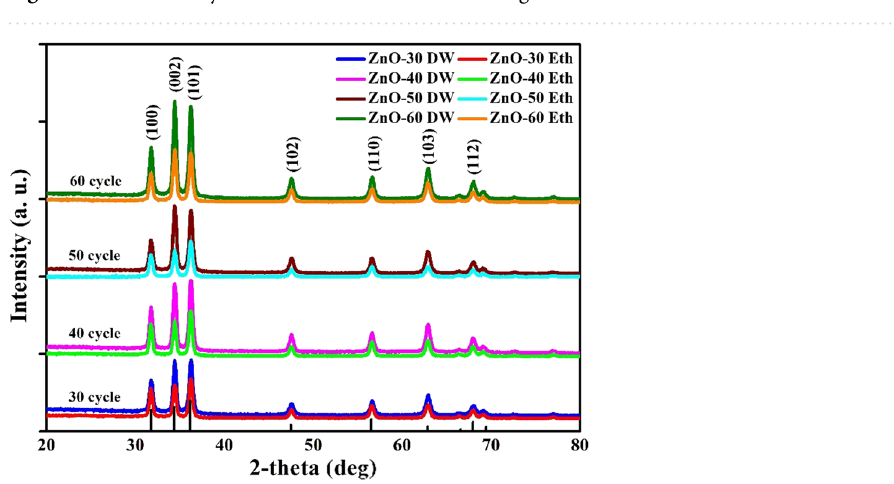
Figure 1. Scheme of synthesis of the ZnO thin films using the SILAR method.